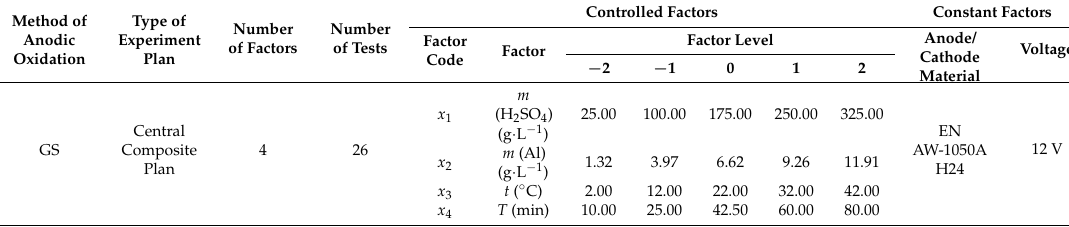
Table 1. GS experimental